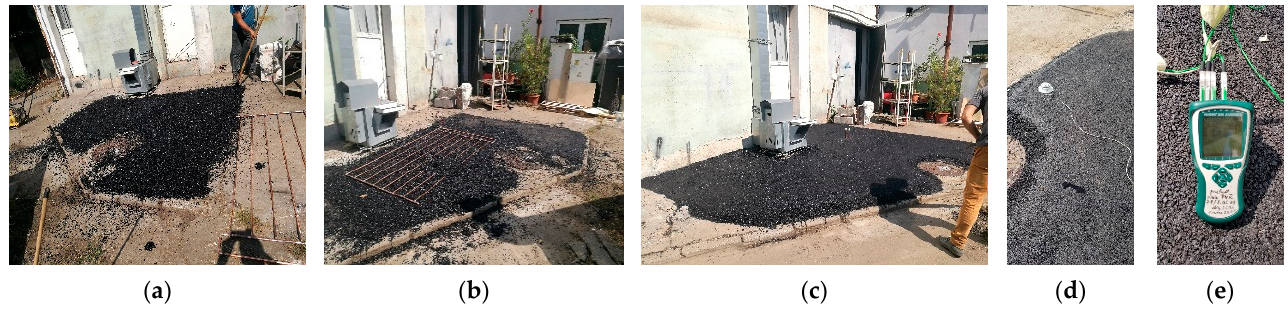
Figure 2. ( a ) Support layer uniformity; ( b ) incorporation of copper register and coating with 5 cm of BA8 asphalt; ( c ) stand after compaction; ( d ) monitoring of solar radiation level with Ahlborn Star Pyranometer FLA 628 S; ( e ) monitoring of temperatures with Ahlborn acquisition station and K-type thermocouples.